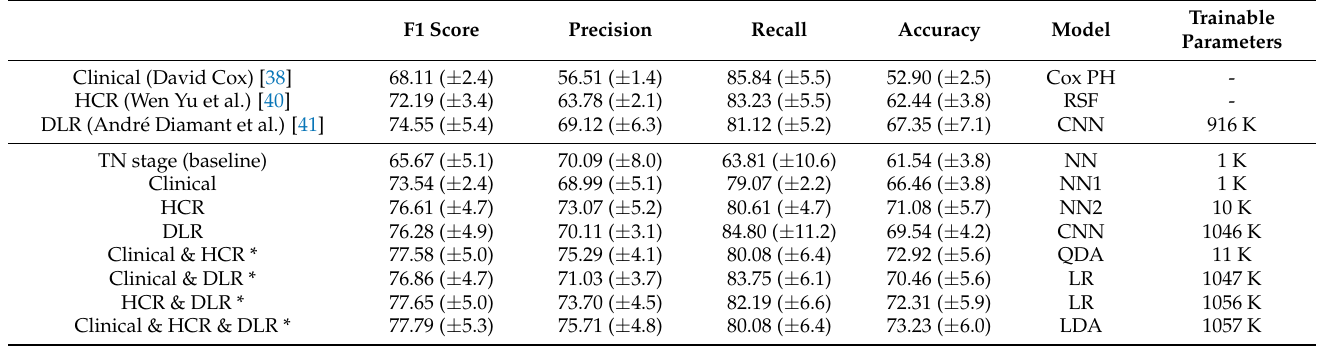
Table 4. Mean and standard deviation values of the 5-fold cross validation in terms of F1 score, precision, recall and accuracy. The first three rows reported the implementation results of other competitive methods using each of our dataset. Type of machine learning model was recorded if the model of the row was ensembled. The number of trainable parameters is displayed in thousands in the rightmost column. The models that shows significant difference with the TN stage (baseline) for all evaluation metrics are marked with an asterisk